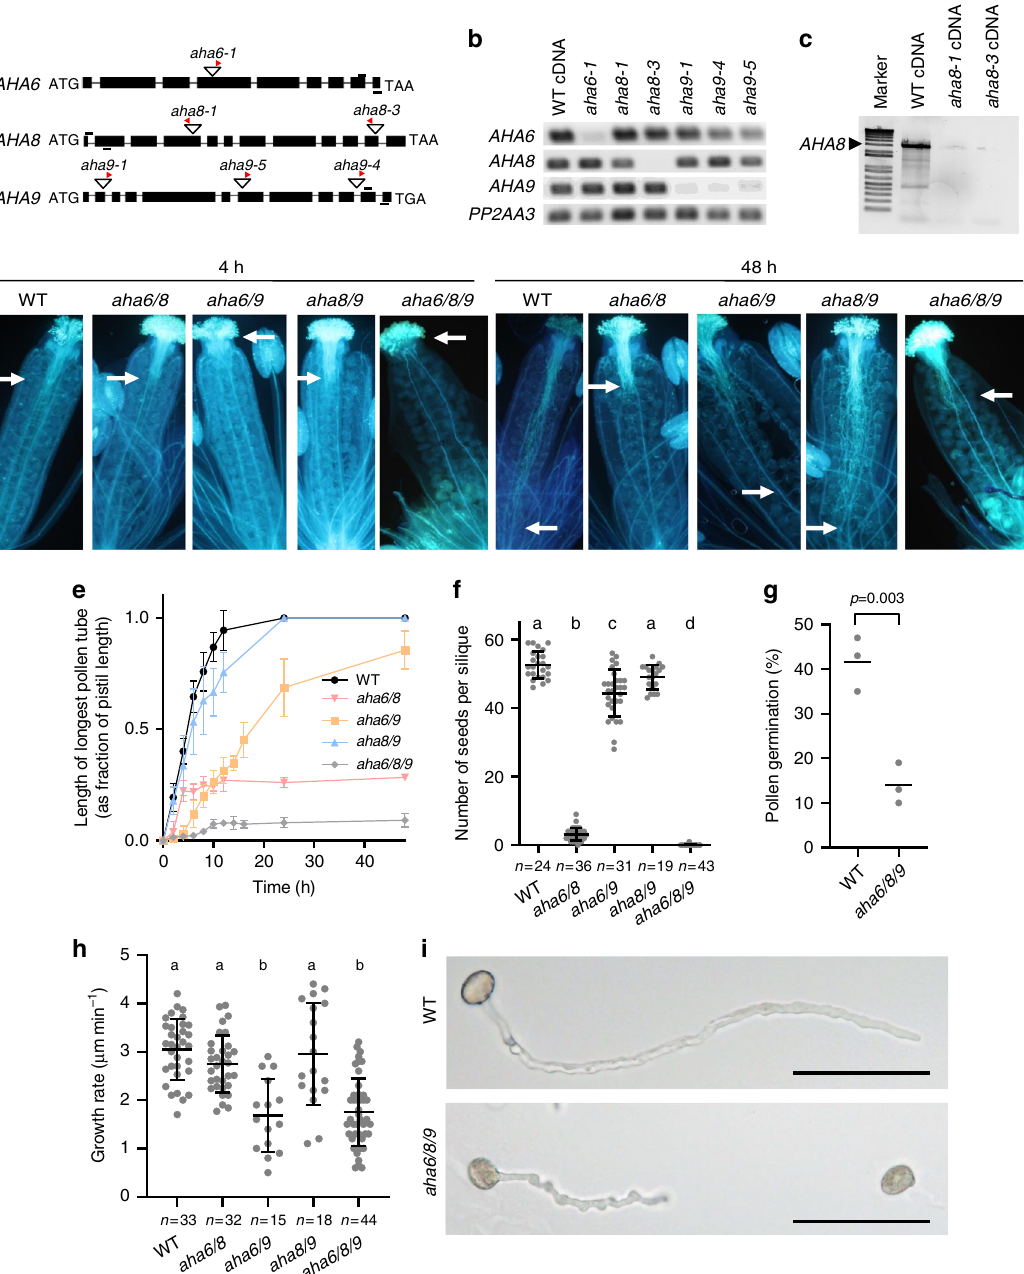
9 W T 6 / 8 8 / 9 6 / 9 6 / 8 / a h a a h a a h a a h a Fig. 2 AHA double and triple mutants display aberrant pollen tube phenotypes. a Diagram of gene structures with position of T-DNA insertions (triangles) in the genes. Red arrowheads indicate the T-DNA left border. Exons are indicated as black rectangles, and introns as black lines. Primers used for reverse-transcription PCR (RT-PCR) are indicated by short black lines above the gene representations. b RT-PCR analysis of T-DNA insertion lines using primer pairs indicated in ( a ). RNA was from fl owers at stage 12 71 . PP2AA3 served as a positive control. c RT-PCR analysis of T-DNA insertion lines using primers that amplify full-length cDNA of AHA8 . d Aniline blue-stained pollen tubes of ms1 pistils pollinated with different aha mutant lines. White arrows indicate the position of the longest tubes at 48 h after pollination. e In vivo pollen tube growth rate (as a fraction of pollen tube length over pistil length), as revealed by aniline blue staining ( n ≥ 3 for all genotypes and time points; error bars show SD). f Number of seeds per silique (one-way ANOVA and Bonferroni ’ s Multiple Comparison Test; p < 0.01; error bars show mean with SD). g In vitro germination rate for WT and aha6/8/9 triple mutant pollen. Means from three individual experiments with ≥ 100 scored pollen grains for each genotype and replicate are shown (two-sided t -test; p < 0.003). h Average pollen tube growth rate assayed in vitro (one-way ANOVA; Bonferroni ’ s test; p < 0.01; error bars show mean with SD). i Light microscopy images of WT and aha6/8/9 pollen tubes grown in vivo. The triple mutant is characterized by short and wavy pollen tubes. Scale bar = 100 µ